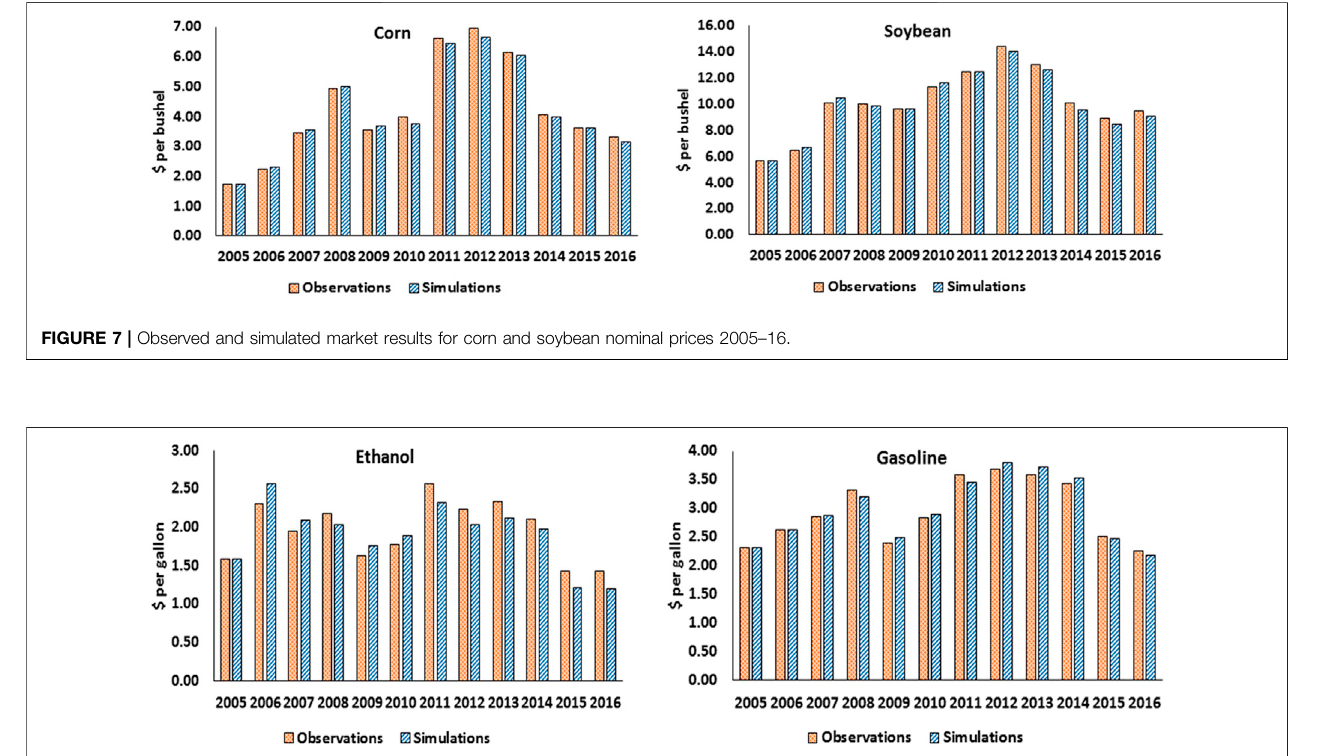
FIGURE 8 | Observed and simulated market results for ethanol and gasoline nominal prices 2005 –